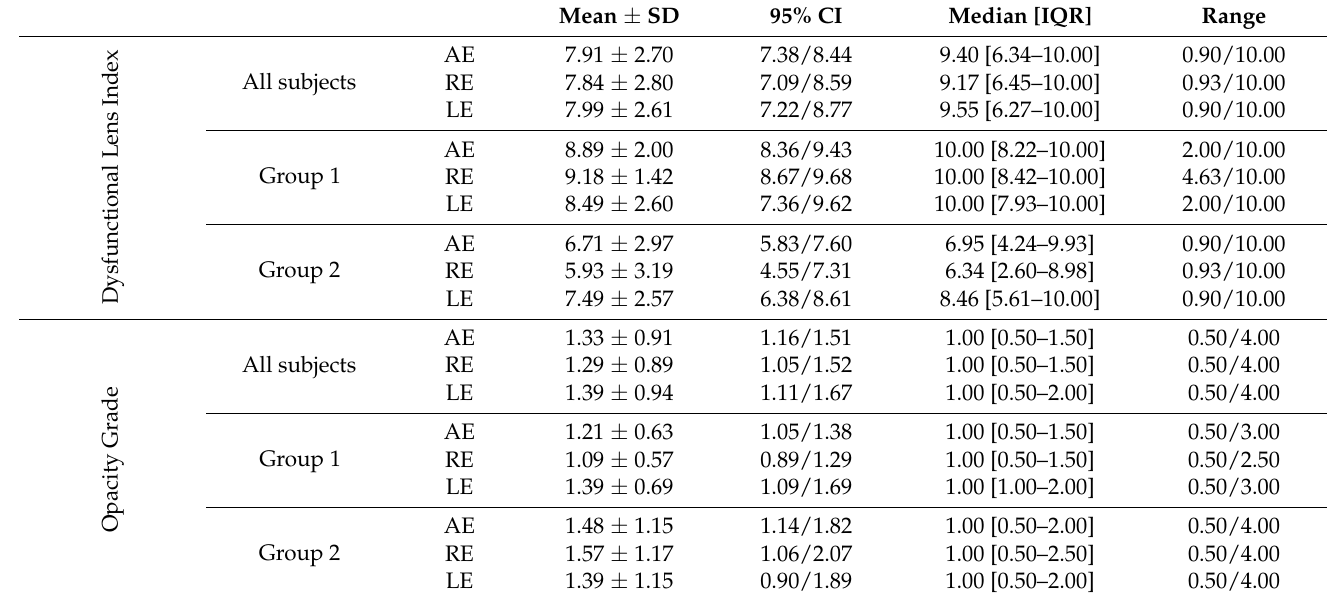
Data are presented as mean ± standard deviation. AE—all eyes; RE—right eye; LE—left eye. Age significantly correlated with DLI for all eyes (Rho = − 0.41, p < 0.001), for right eyes (Rho = − 0.51, p < 0.001), and almost reached significance for left eyes (Rho = − 0.26, p = 0.08). Gender did not have a significant influence on DLI for all eyes ( p = 0.27), right eyes ( p = 0.07), nor left eyes ( p =